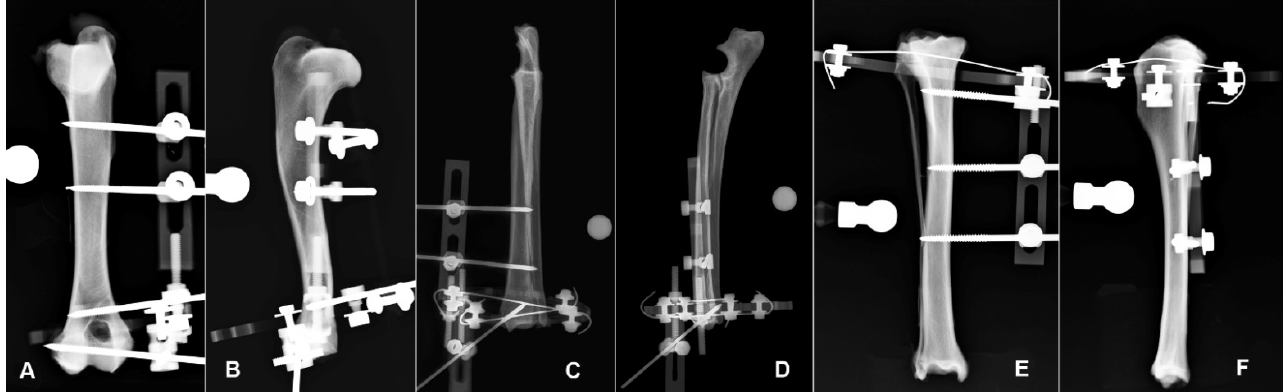
Figure 2. Hybrid frame application to the humerus for potential stabilization of a fracture in the planned fracture area (FA) in the CrCd ( A ) and ML ( B ) radiographic view. Hybrid frame application to the radius-ulna for potential stabilization of a fracture in the planned fracture area (FA) in the CrCd ( C ) and ML ( D ) radiographic view. Hybrid frame application to the tibia for potential stabilization of a fracture in the planned fracture area (FA) in the CrCd ( E ) and ML ( F ) radiographic view. Note that in each bone segment, the bone is still visible underneath the frame structure in both pro- jections.